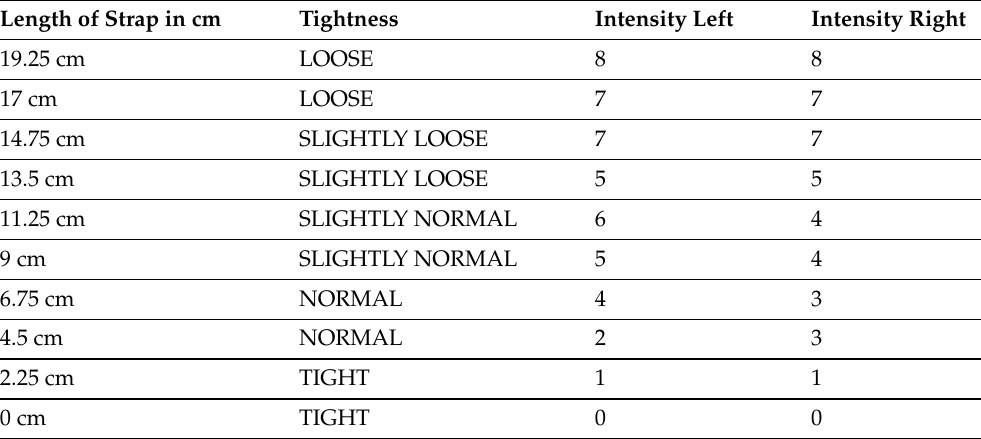
Table 3. Readings of the experiment of light intensity sensors with fabric